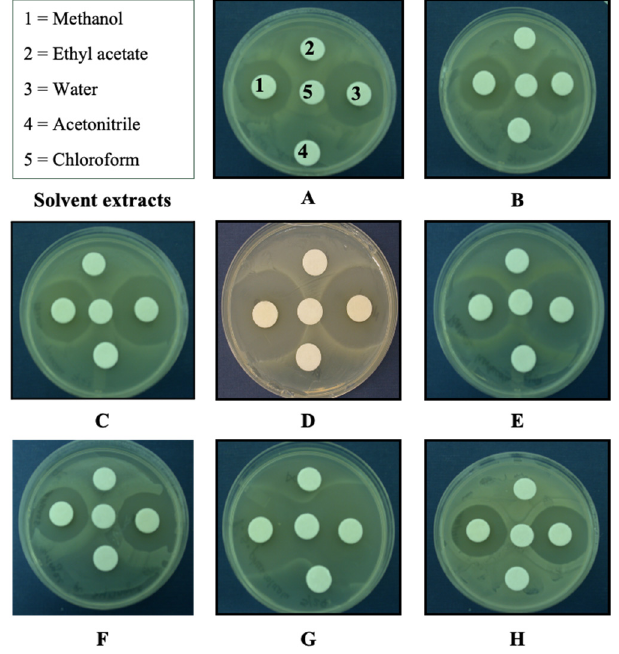
Figure 1. Antibacterial activity of extracted freeze-dried culture fluids of Ganoderma lucidum using five different solvents. Test bacteria: A = Acidovorax avenae , B = Agrobacterium tumefaciens , C = Brenneria quercina , D = Erwinia carotovora subsp. carotovora , E = Pantoea herbicola , F = Pseudomonas syringae pv. syringae , G = Pseudomonas syringae pv. phaseolicola , and H = Xanthomonas campestris pv. campestris . Table 2. Effect of protein digestion and dialysis tubing assays on antibacterial activity of culture fluids produced by G. lucidum .